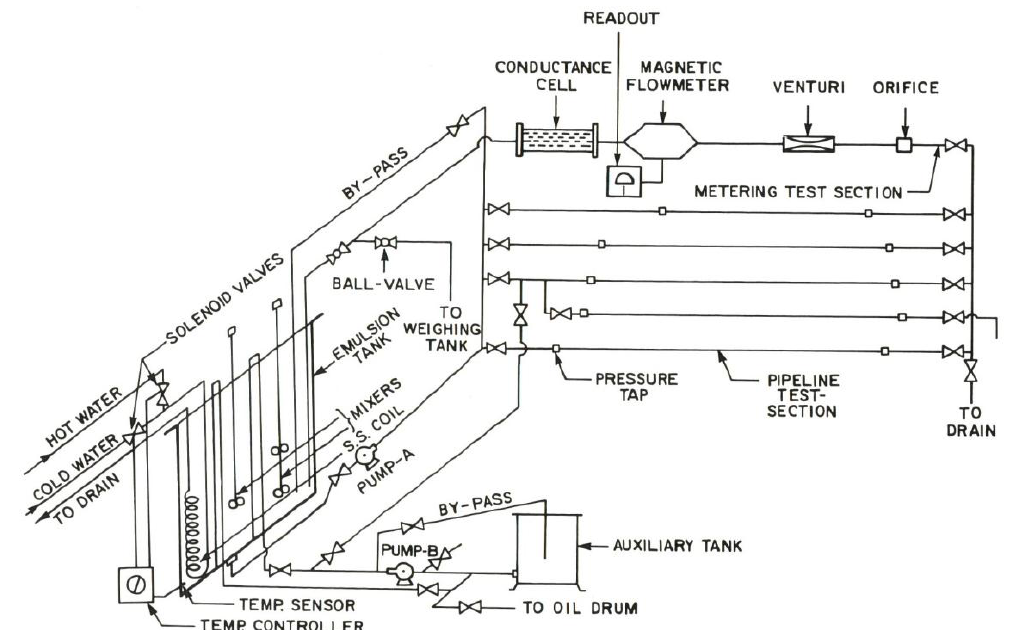
Figure 1. Schematic diagram of the flow